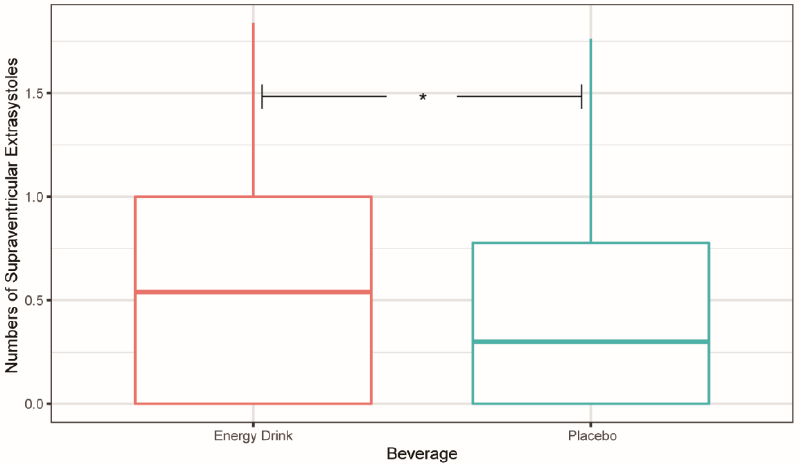
Figure 1. Number of supraventricular extrasystoles (SVES) within the first four hours after energy drink and placebo ingestion. The numbers of SVES were transformed by lg( n + 1). * p <